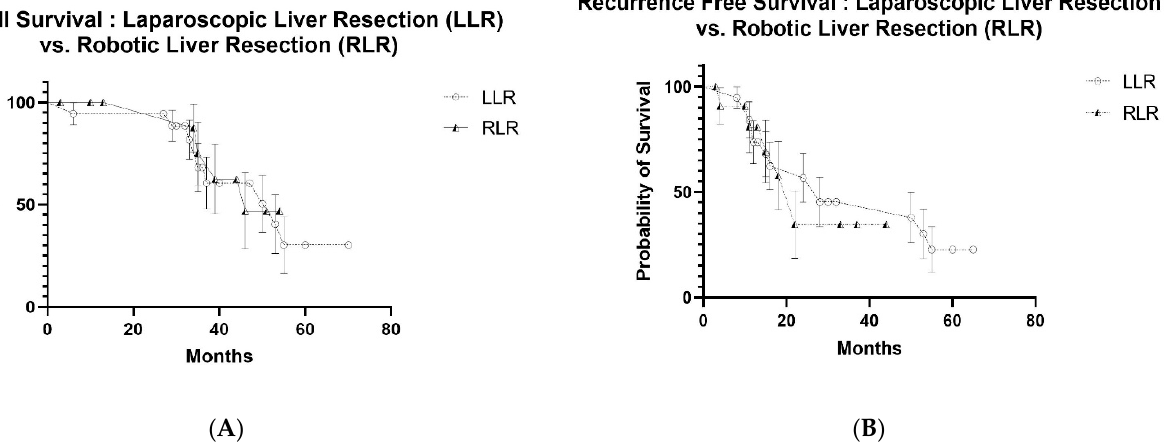
Figure 2. ( A ) Overall survival curves for open liver resection (OLR) vs. robotic liver resection (RLR) after propensity score matching (PSM) for colorectal liver metastases (CRLMs), ( B ) recurrence-free survival curves for open liver resection (OLR) vs. robotic liver resection (RLR) after Propensity Score Matching (PSM) for colorectal liver metastases (CRLMs).